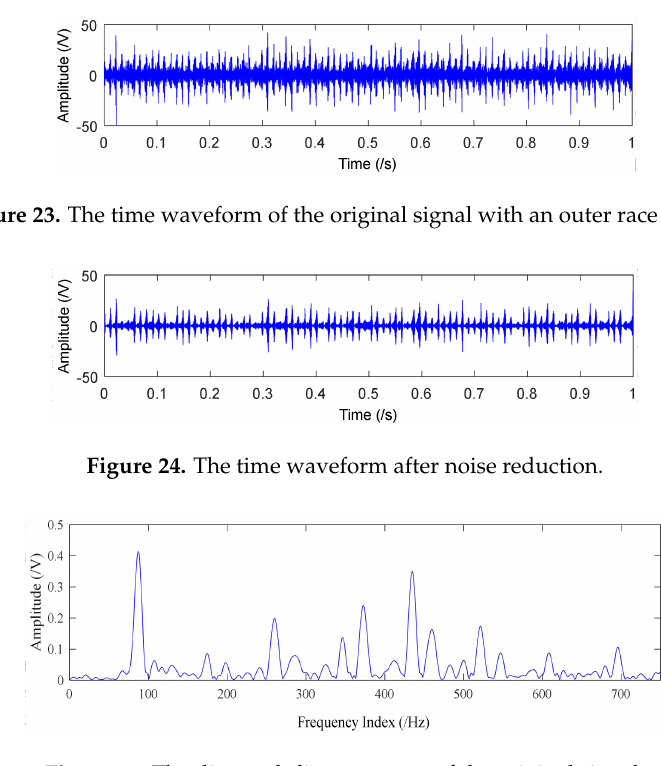
Figure 25. The diagonal slice spectrum of the original